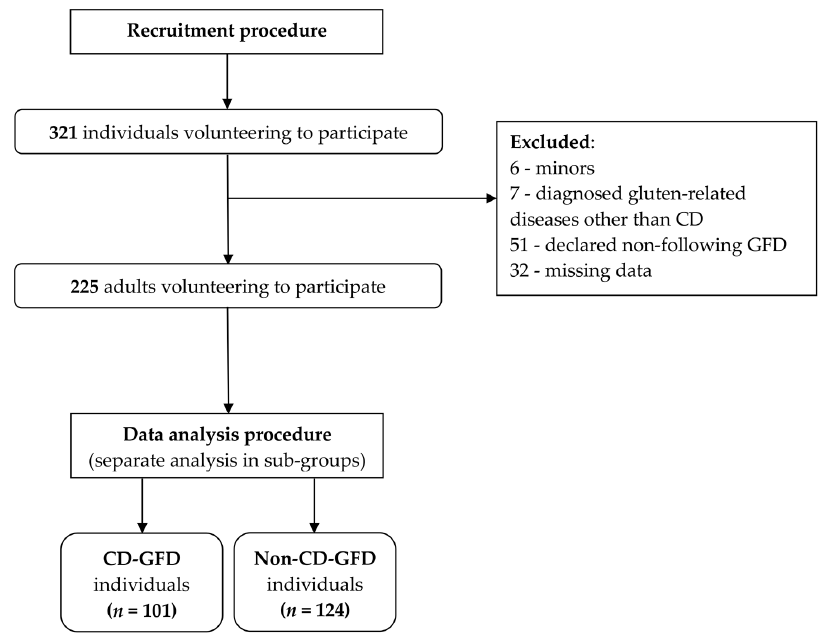
Figure 1. Participants included to the study.